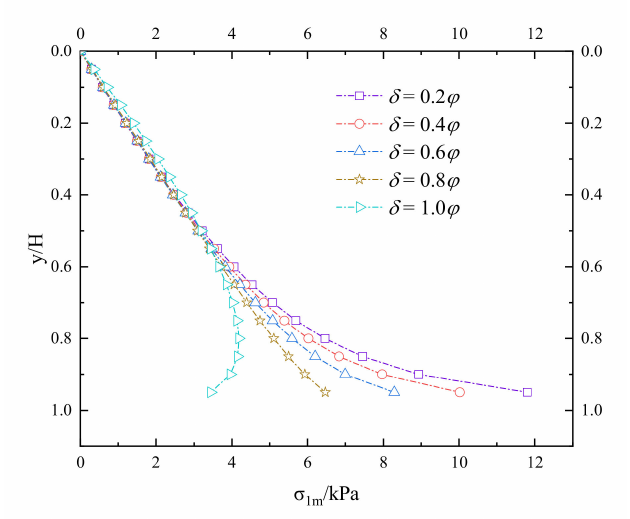
Figure 6. Horizontal active earth pressure distribution along wall depth with varying interface friction angles δ